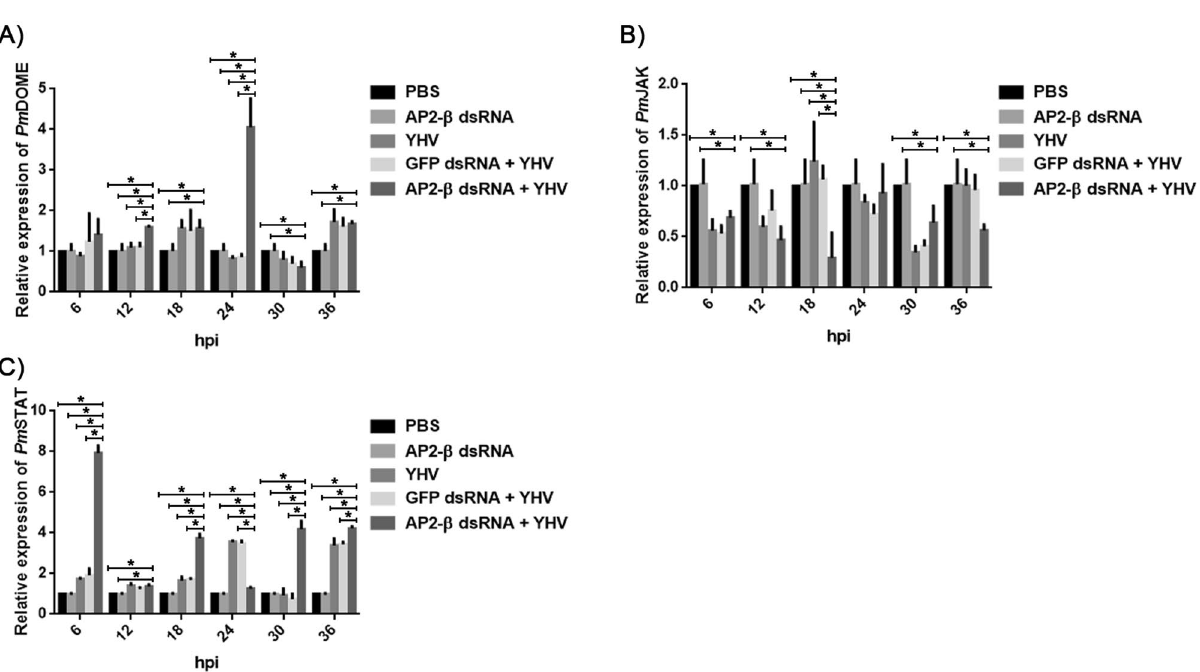
Figure 4. Effect of Pm AP2-β silencing on the JAK/STAT pathways during YHV infection. Pm AP2-β knockdown was carried out as described in "Methods". The transcription levels of Pm DOME ( A ), Pm JAK ( B ) and Pm STAT ( C ) at 6, 12, 18, 24, 30, 36 h after YHV infection were determined by qRT-PCR. The data are shown as the mean ± standard deviation. An asterisk represents significant differences from control group ( p < 0.05). The experiment was carried out in